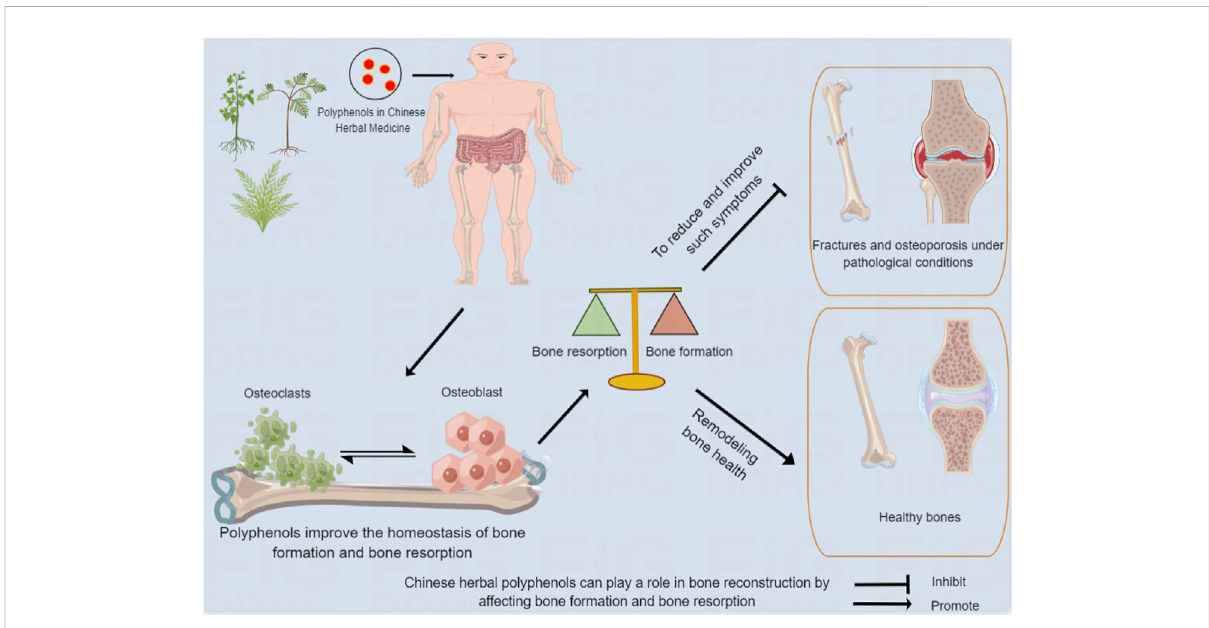
Chineseherbalpolyphenolscanplayaroleinbonereconstructionbyaffectingboneformationandboneresorption.Afterbeingabsorbedinthe gastrointestinal tract, Chinese medicine polyphenols act on human bones, and improve bone absorption and bone formation, contributing to bone remodeling and health, and reducing and improving adverse